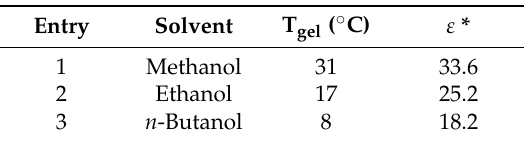
Table 2. Gel-sol transition temperatures for gels of acid 2 (1 wt %) in three different alcohols and their dielectric